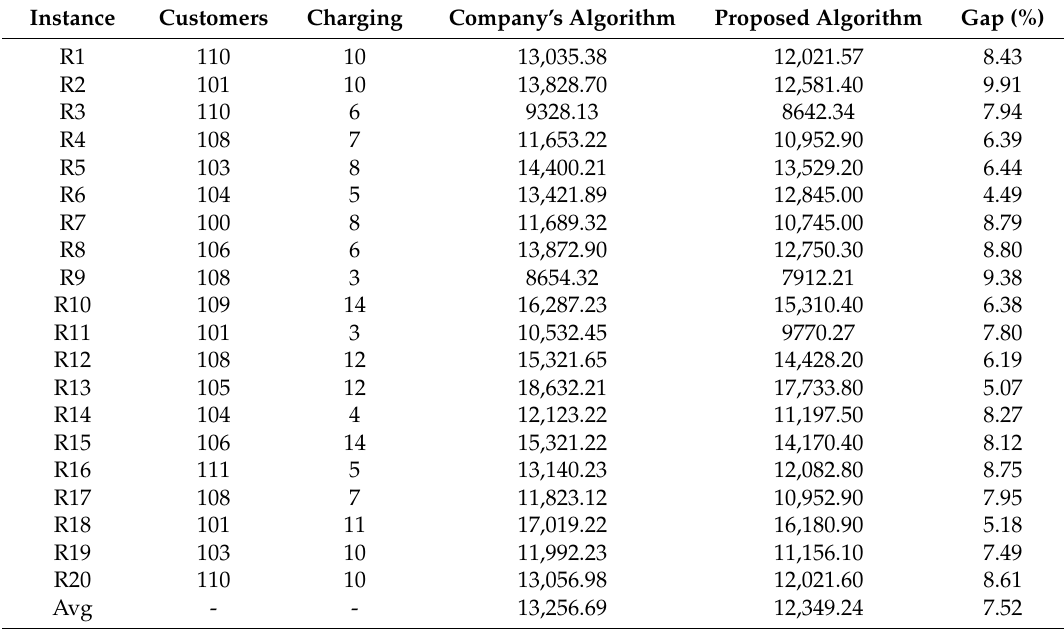
Table 5. Results of instances obtained by company’s algorithm and the proposed